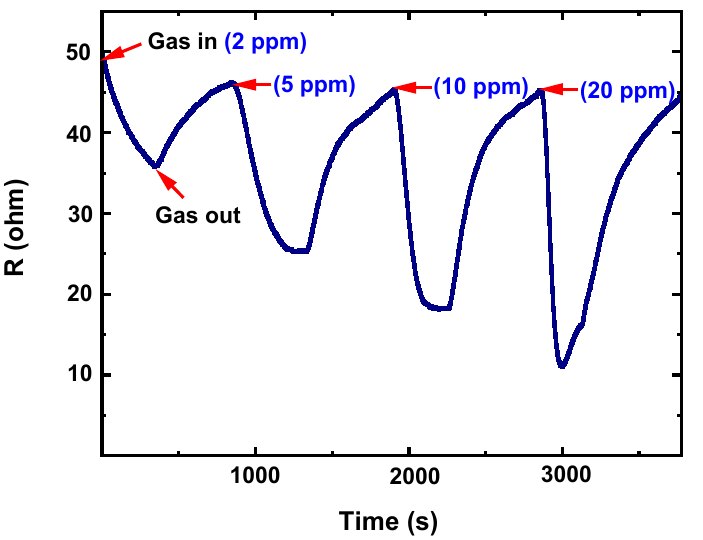
Figure 7. Dynamic resistance of the Ag NPs/V 2 O 5 thin film/Au NPs sensor exposure to acetone gas with different concentrations ranging from 2 ppm to 20 ppm at 150 °C.